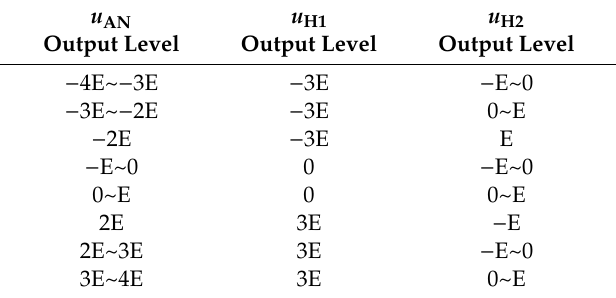
Table 2. Synthesis method of voltage with Hybrid Frequency Pulse Width Modulation (HF-PWM).